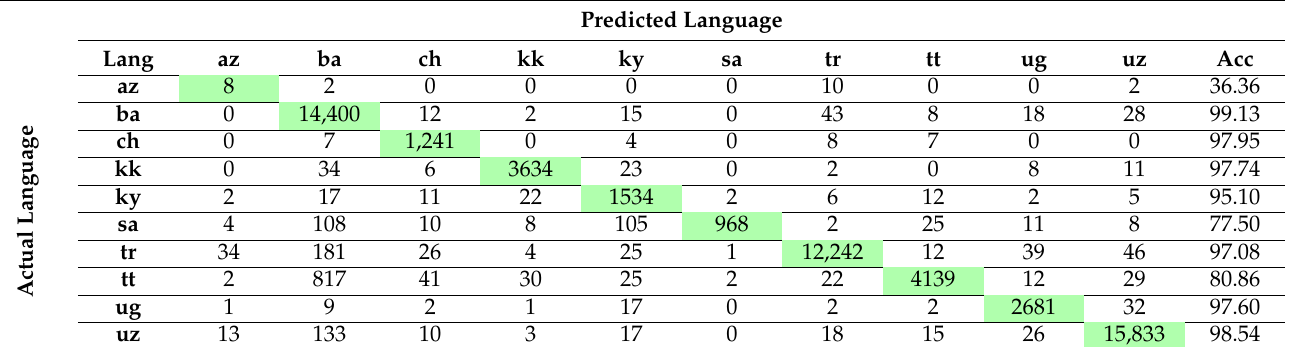
Table 10. Language identification confusion matrix and accuracy (Acc, %) of the all_turkic model for different Turkic languages on the combined test sets (CVC, KSC, TSC, and USC). Predicted